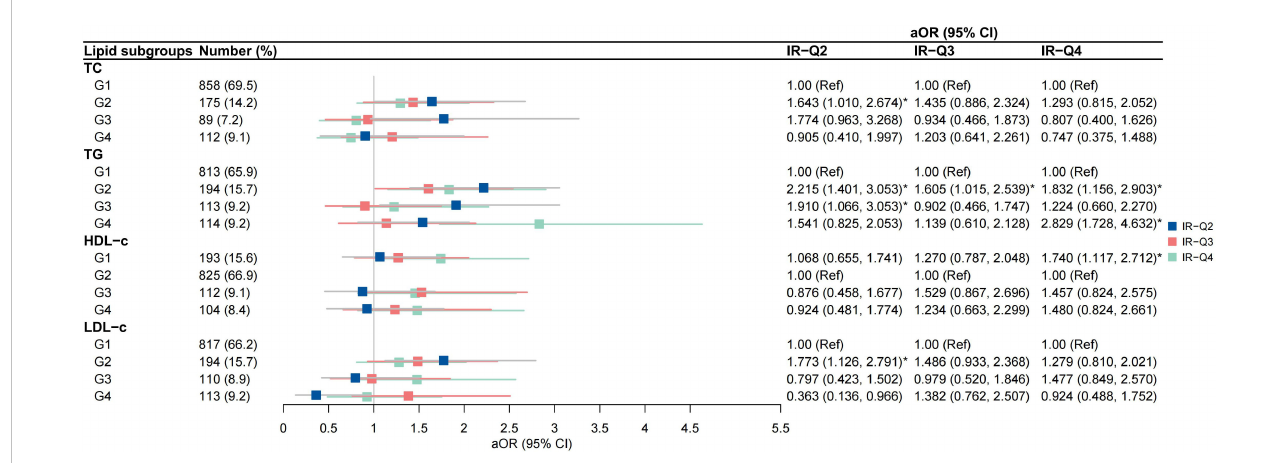
FIGURE 5 Associations between trends in lipid pro fi les and trends in insulin resistance calculated by QUICKI IR-Q2, pregnancies with persistently low QUICKI in both the fi rst and second trimesters; IR-Q3 group, pregnancies with fi rst-trimester low QUICKI alone; IR-Q4 group, pregnancies with second-trimester high low QUICKI